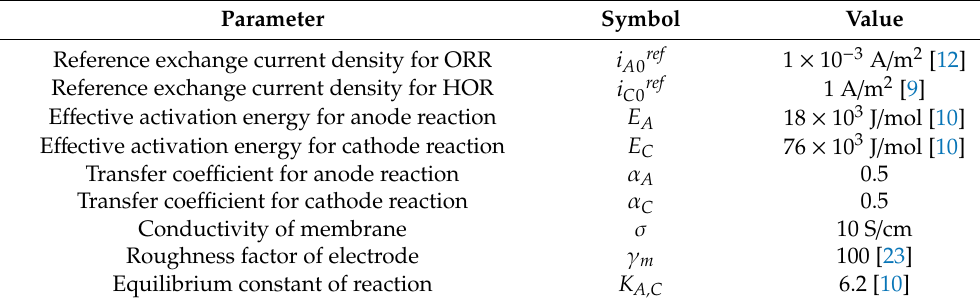
Table 2. Parameters of the electrochemical